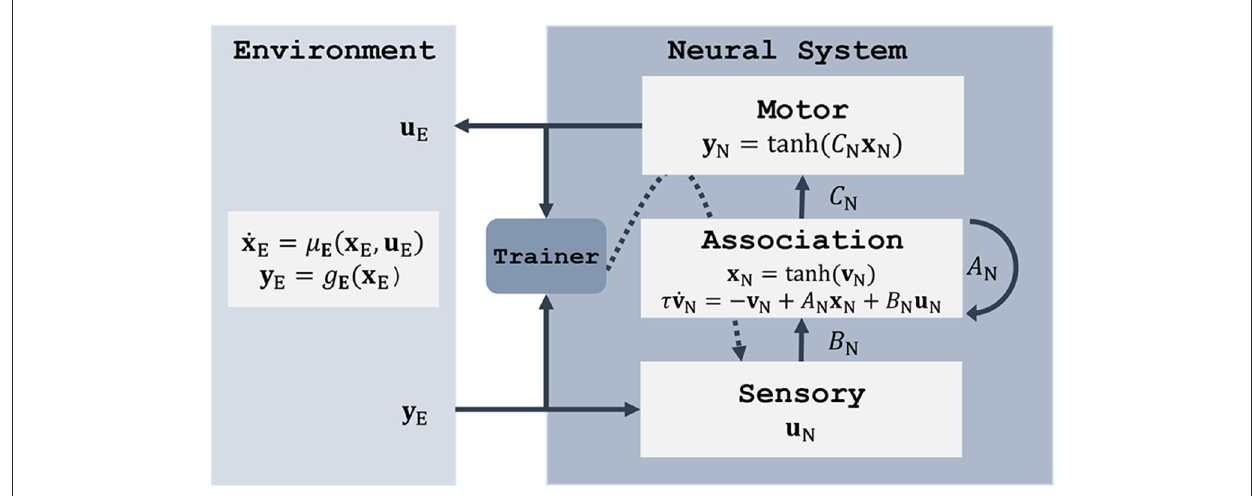
FIGURE2 Both the environment and the neural system are modeled as dynamical systems using ordinary or stochastic differential equations. Here, the neural system is represented by an RNN with a sensory input component, a motor output component, and an association area which provides the input-output mapping. The system can be trained using backpropagation through time (Werbos, 1990).